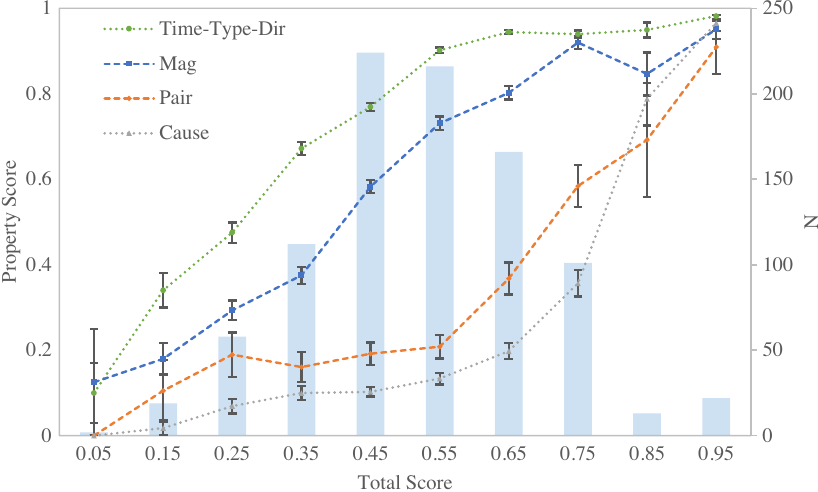
FIG. 2. Plot of property subscores across total scores (with error bars denoting standard error) for all students in this study. Frequency of total score distribution is shown as a bar chart in the background, with absolute count of students falling into each range shown on the right axis. The results are based on pre- and post-test data from all